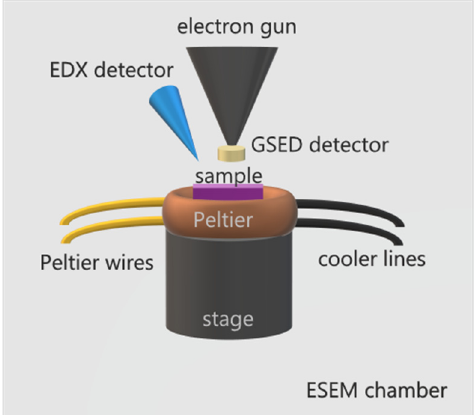
Figure 1. Scheme of ESEM for ice formation and sublimation studies. The sample is placed on top of a Peltier element, able to cool down a sample to temperatures around − 30 °C, equipped with cooler circuit lines and Peltier wires for temperature control. The Peltier stage is assembled on top of SEM’s motorized stage. A specially designed GSED detector is attached to the gun nozzle. Additionally, an EDX detector may be used for spectroscopic analysis. The assembly is enclosed in the ESEM chamber, which may be filled with water vapor up to 100 % RH or even supersaturation conditions.